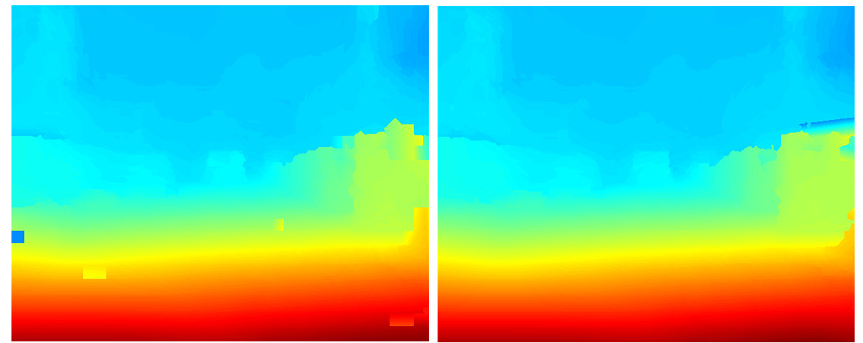
Figure 7. Left: the original SPS disparity. Right: the disparity after interpolation.